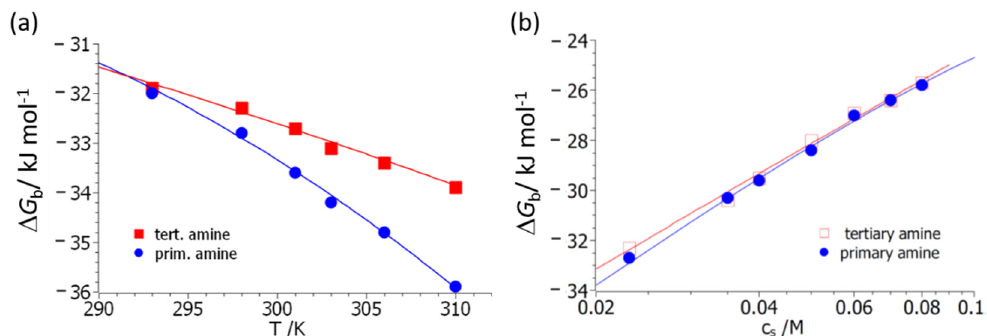
Figure 4. Comparison of theory and experiment. ( a ) The free energy of binding, Δ G b , is plotted against the temperature for polymers 3 (primary amine) and 4 (tertiary dimethyl amine). The salt concentration was fixed at c s = 23 mM for all data. ( b ) The free energy of binding, Δ G b , is plotted against the salt concentration, c s , at a fixed temperature of 298 K for polymers 3 (primary amine) and 4 (tertiary dimethyl amine). The solid lines mark the fit by Equation (14) in both figures.